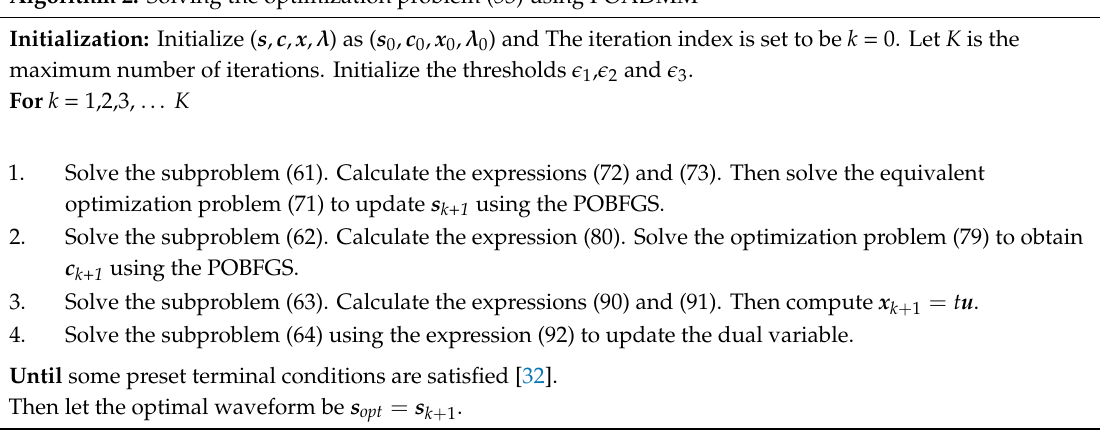
Algorithm 2: Solving the optimization problem (53) using